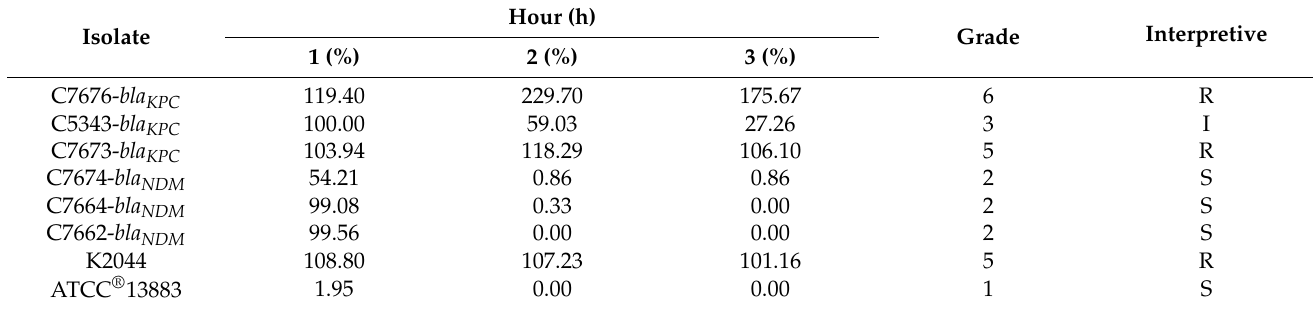
Table 3. Serum resistance analysis based on serum killing assay.